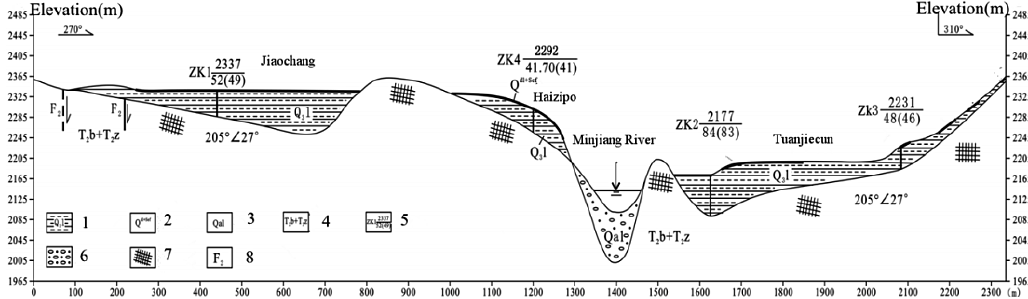
Figure 3. Typical cross section of the Diexi barrier lake (Section III–III’ in Fig. 2.)